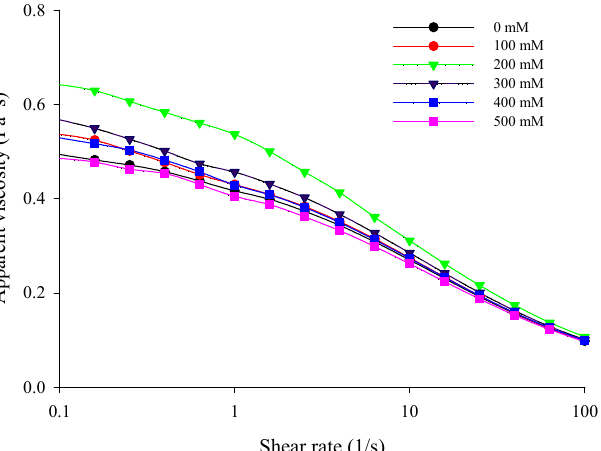
Figure 3. Effects of NaCl concentration on the zeta-potential of filled hydrogels during storage. Different letters from A to D indicate significant differences for different NaCl concentration at same days ( p < 0.05); Different letters from a to b indicate significant differences for different days at same NaCl concentration ( p < 0.05).